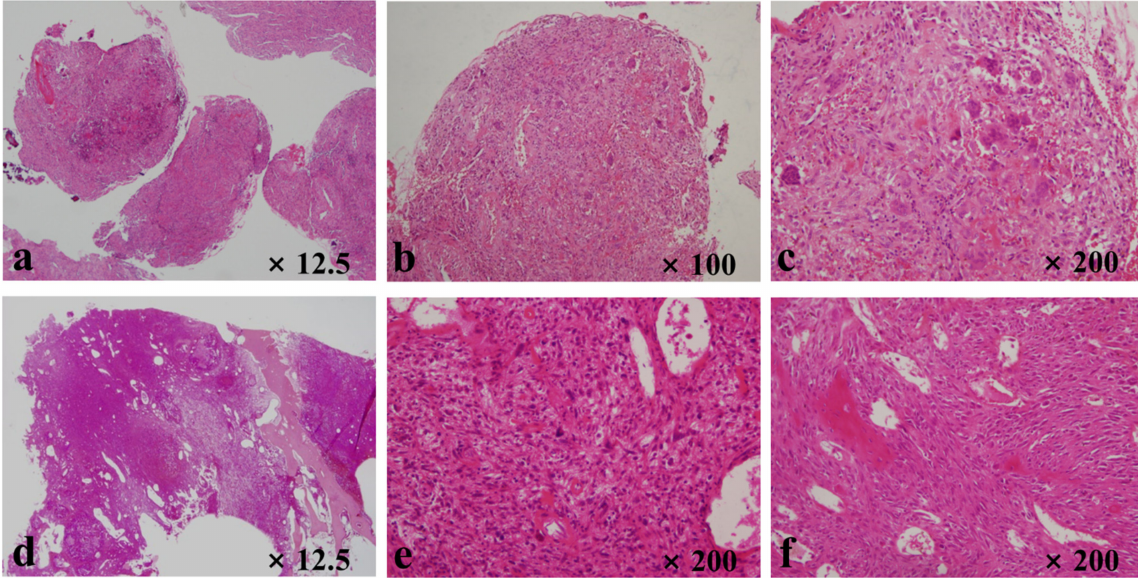
Figure 2. Histopathologic evaluation of the sixth case listed in Table 1. The slides of benign giant cell tumor of bone show ( a ) fibrous tissues with giant cells, ( b ) giant cells and histiocytes, and ( c ) spindle-cell lesions with giant cells and histiocytes. Slides related to secondary malignancy in giant cell tumors demonstrate ( d ) lesion filling most of the intramedullary space in the distal femur, ( e ) malignant spindle cells with a few giant cells, and ( f ) malignant